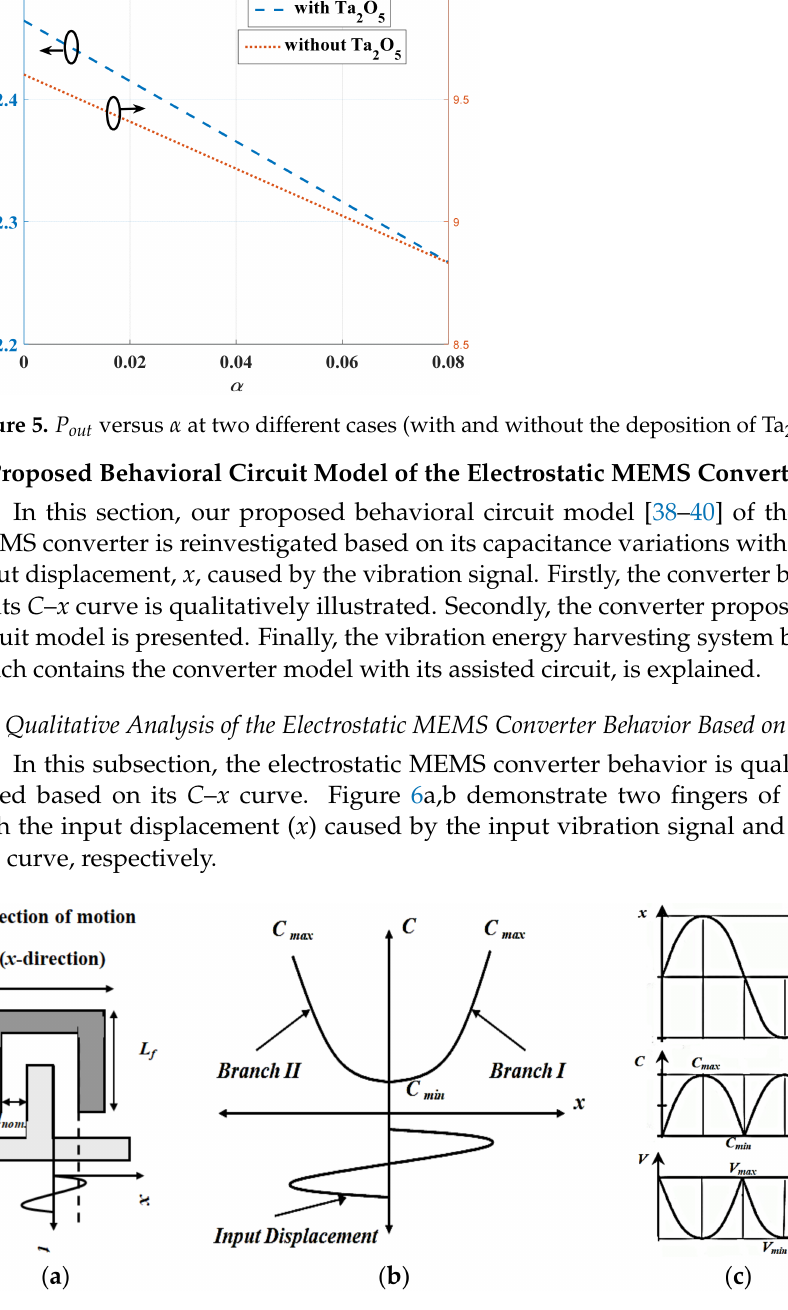
Figure 6. Qualitative analysis of the converter behavior ( a ) The converter two fingers representation, ( b ) The converter C – x curve, and ( c ) The input displacement ( x ), changes in capacitance and converter output